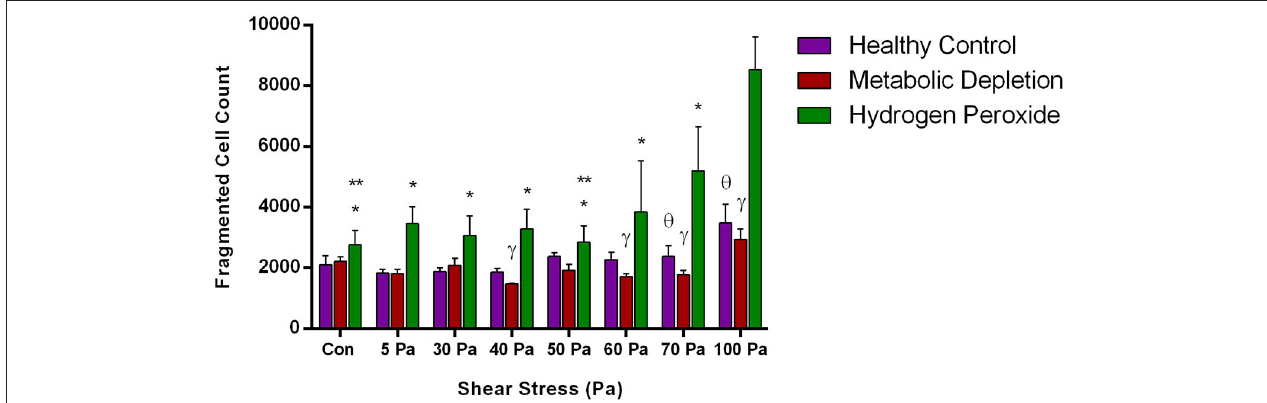
FIGURE 5 | The change in the number of fragmented RBCs in the healthy control group and in the damage models with different levels of applied SS. Data are mean ± SEM of n = 5. * p < 0.05, difference from 100Pa; ** p < 0.05, difference from 70Pa; γ p < 0.05, difference between metabolic depletion and oxidative damage groups; θ p < 0.05, difference between healthy control and oxidative damage groups (one-way